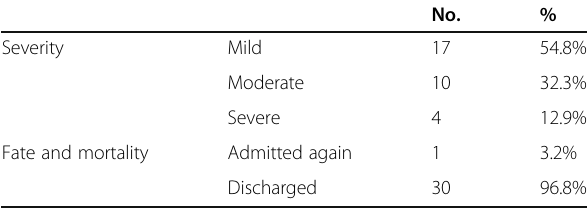
Table 2 Distribution of severity, and fate, and mortality